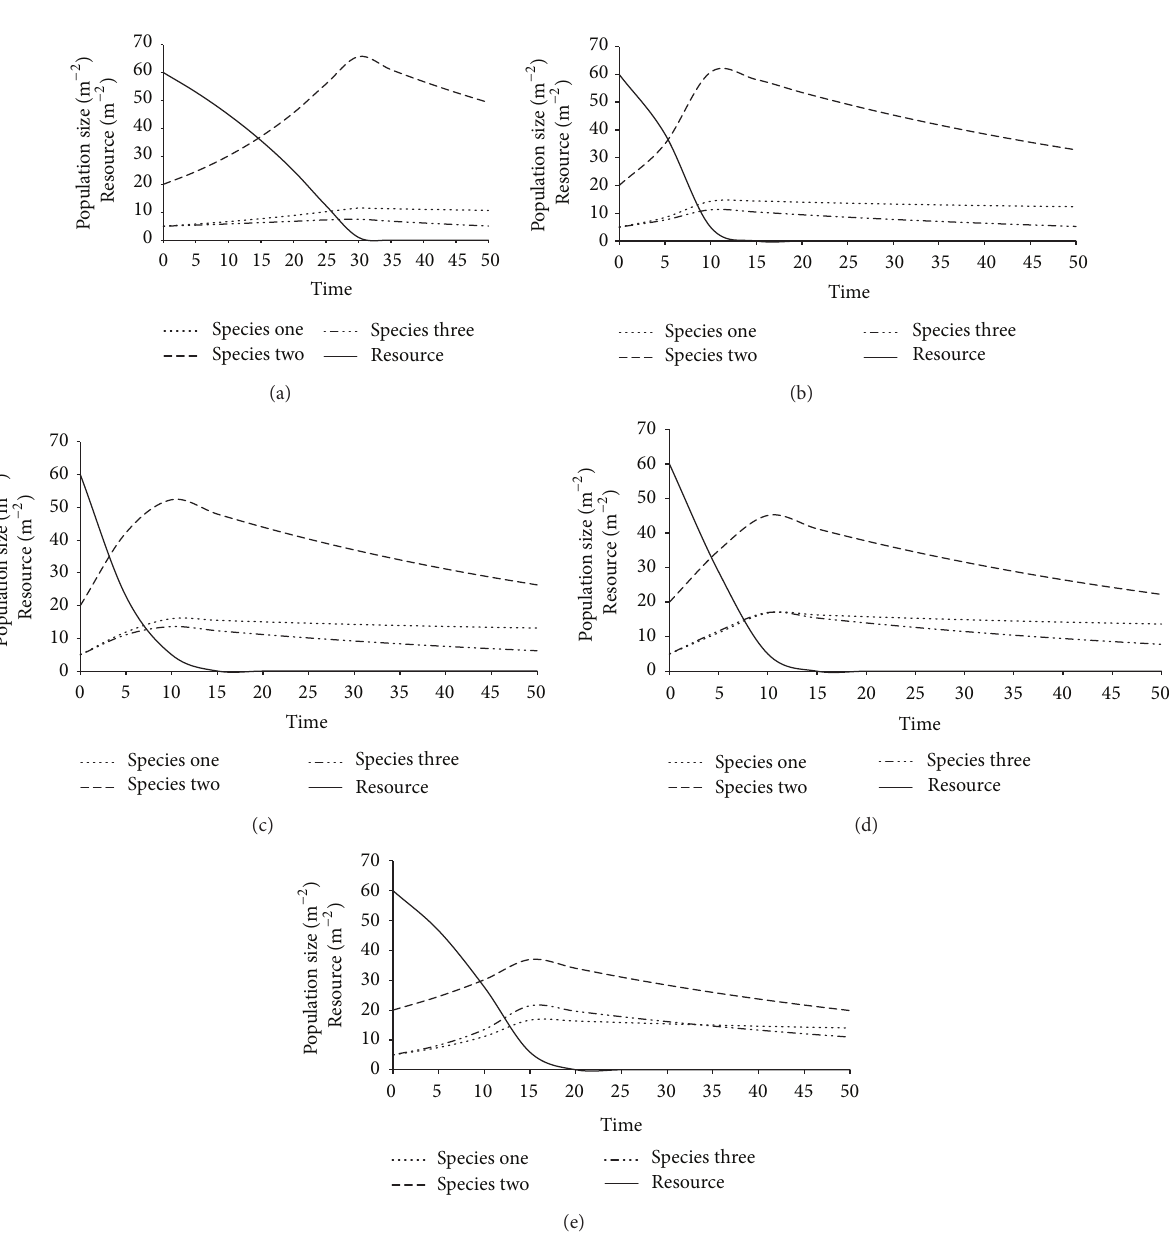
Figure 8: Behavior of the isoclines when the population size of species two is greater than that of species one and three; curves (a)–(e) show the behavior of population size for each species and resource at temperatures 10 ∘ C, 15 ∘ C, 20 ∘ C, 25 ∘ C, and 30 ∘ C,